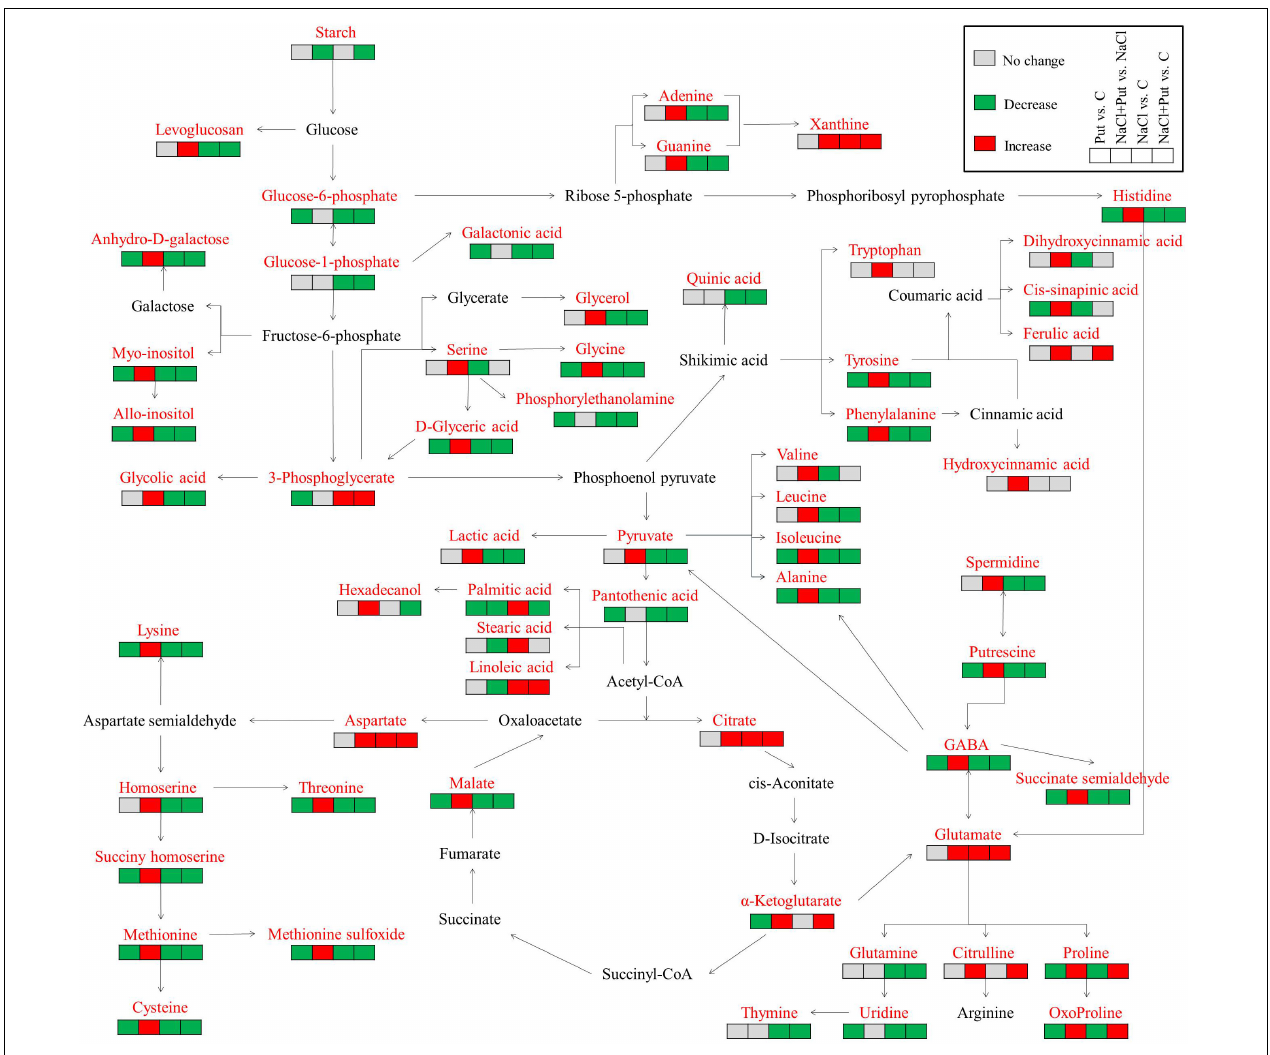
FIGURE 8 | An assessment of 60 metabolites in the map of metabolic pathways. Red, green, and gray mean the significant increase, decrease, and unchanged,